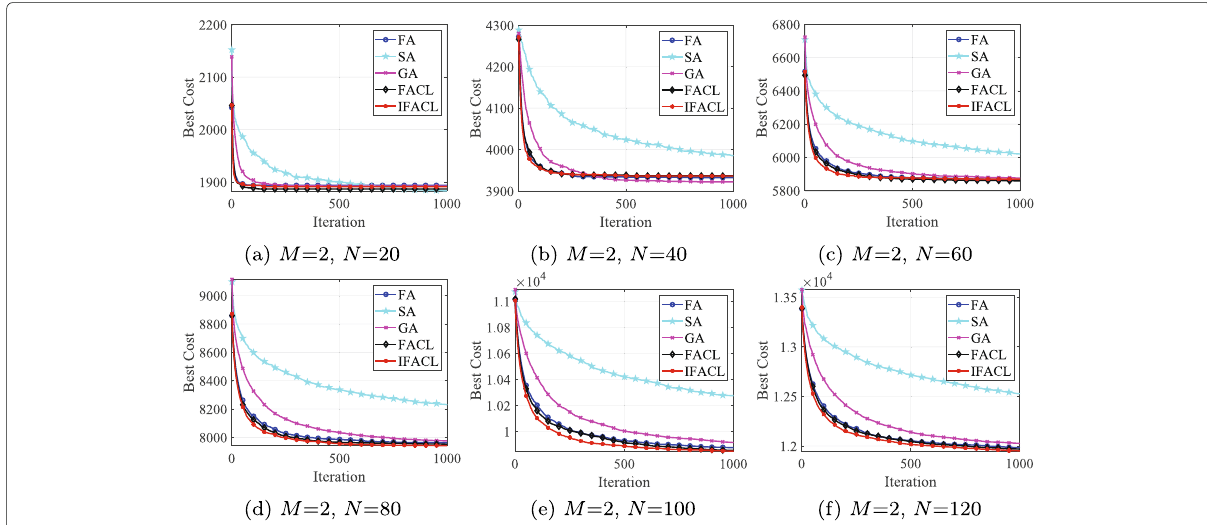
Fig. 8 Average convergence curve for each algorithm on SDominant instances of Dataset1 when the number of machines M =2